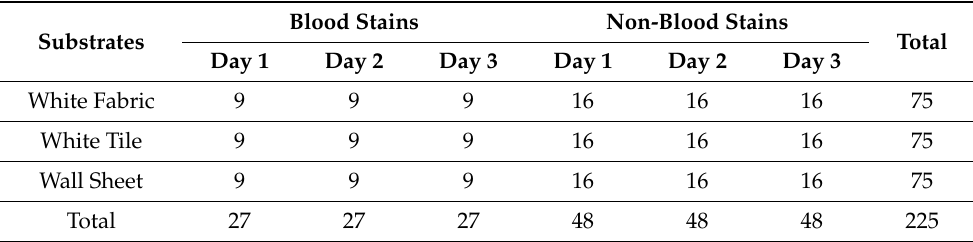
Table 1. The number of stains on each substrate: In total 81 blood and 144 non-blood stains are collected. In total 225 samples (HSI cubes) are collected for an experimental setup in which each HSI cube is later reduced to 100 × 100 × 224 after extracting the Region of Interest (ROI).